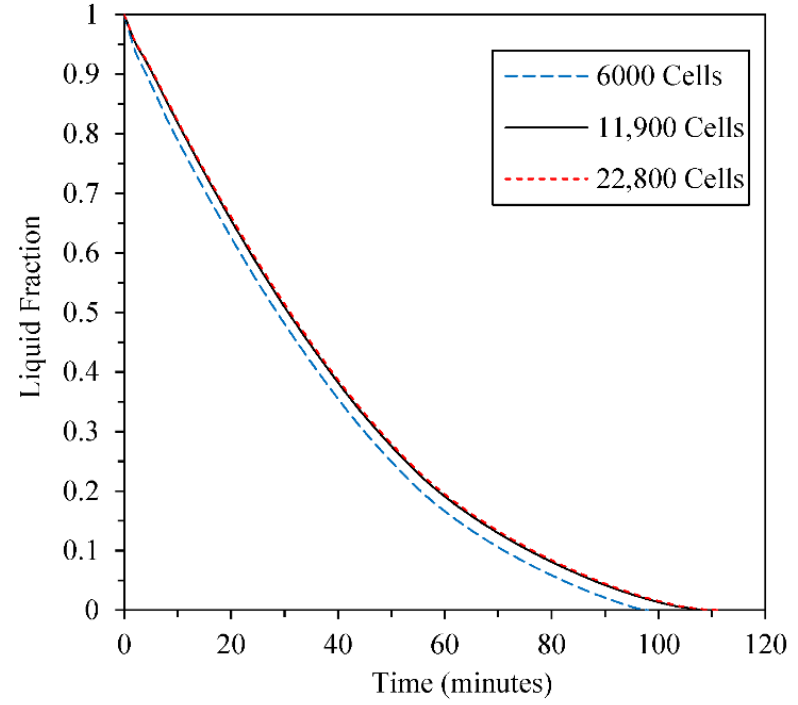
Figure 4. Effect of grid size on the transient liquid fraction in TES with configuration of case-6.